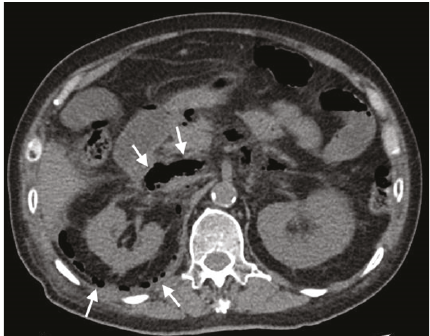
Figure 3: CT scan of abdomen showing pneumoperitoneum at region of 2nd and 3rd part of the duodenum with retroperitoneal air involving the right perinephric region.